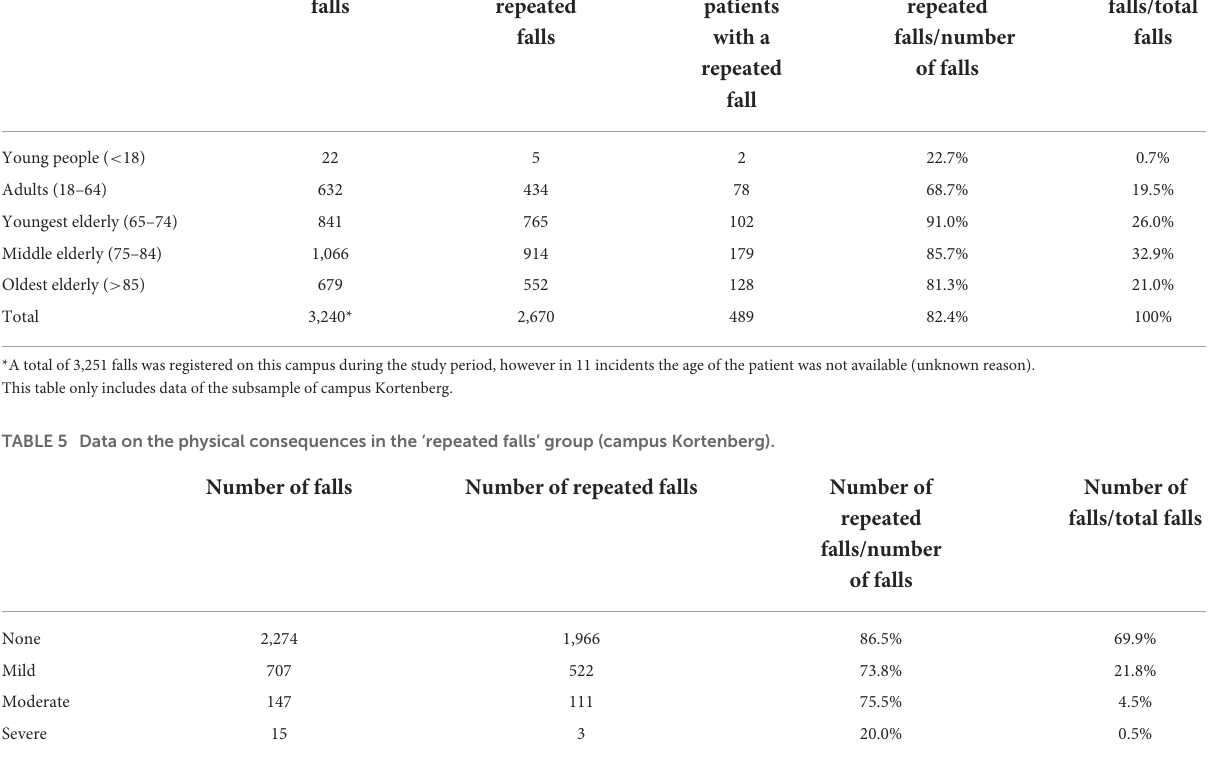
Number of repeated falls